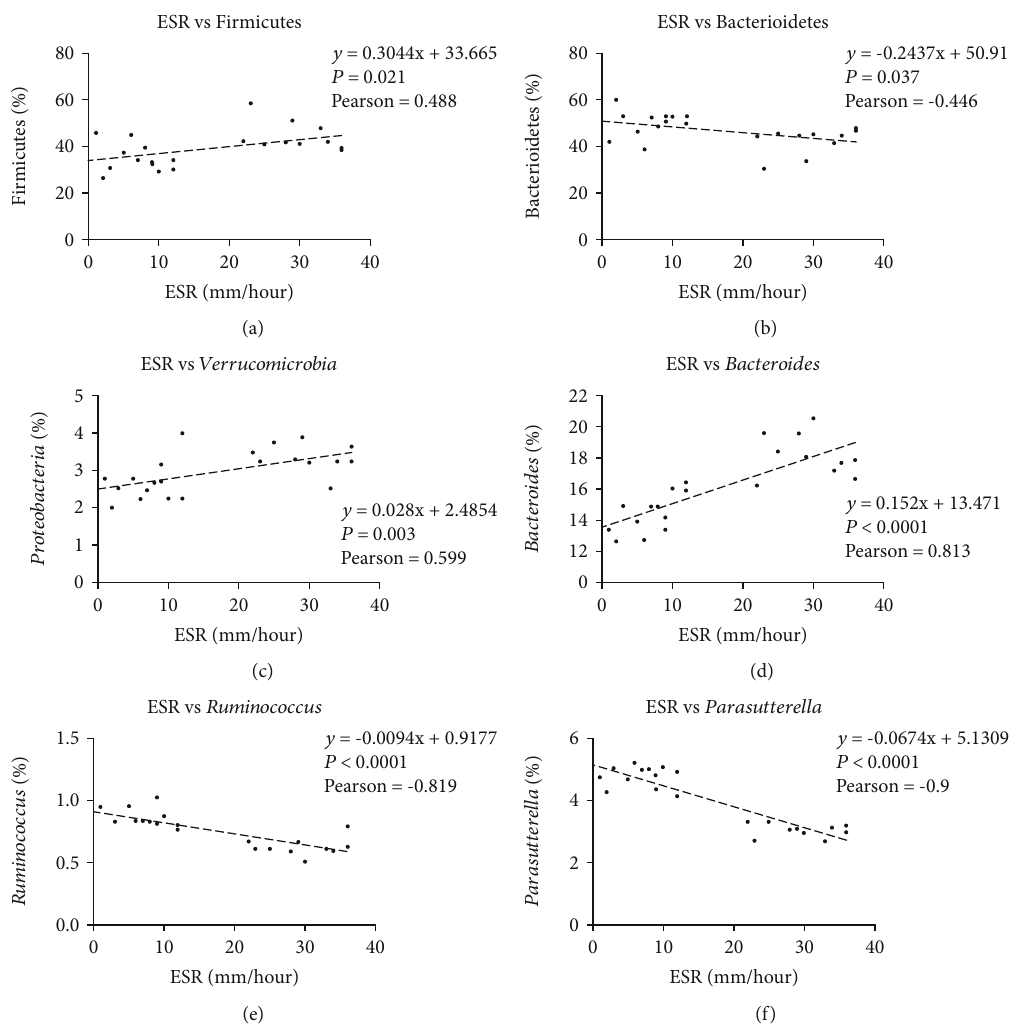
Figure 5: The association of microbiota with ESR. (a) Positive correlation between Bacteroidetes abundance and ESR; (b) Inverse correlation between Firmicutes and ESR; (c) Positive correlation between Verrucomicrobia and ESR; (d) Positive correlation between Bacteroides and ESR; (e) Inverse correlation between Ruminococcus and ESR; (f) Positive correlation between Parasutterella and